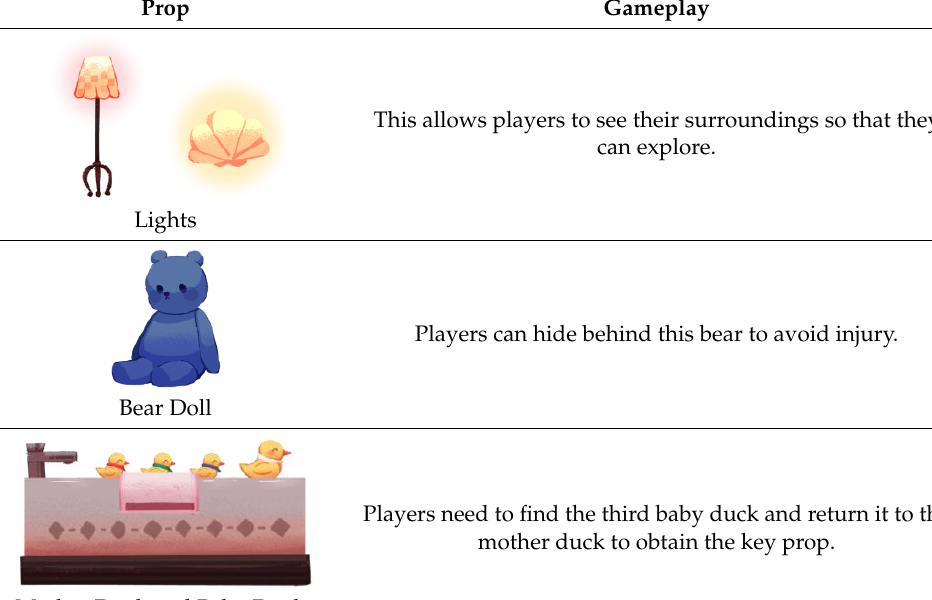
Figure 3. Operation of investigating and hiding. Table 8. Partial props. Table 8. Partial props. Prop